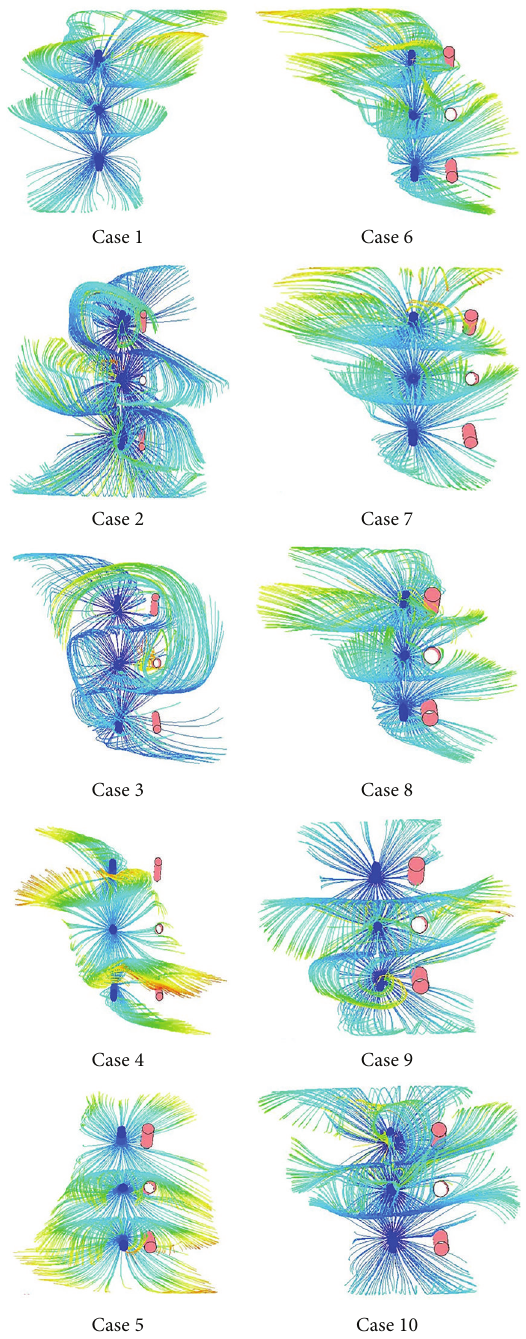
Figure 7: Distributions of droplets particle track in different cases with uniform droplet mass and